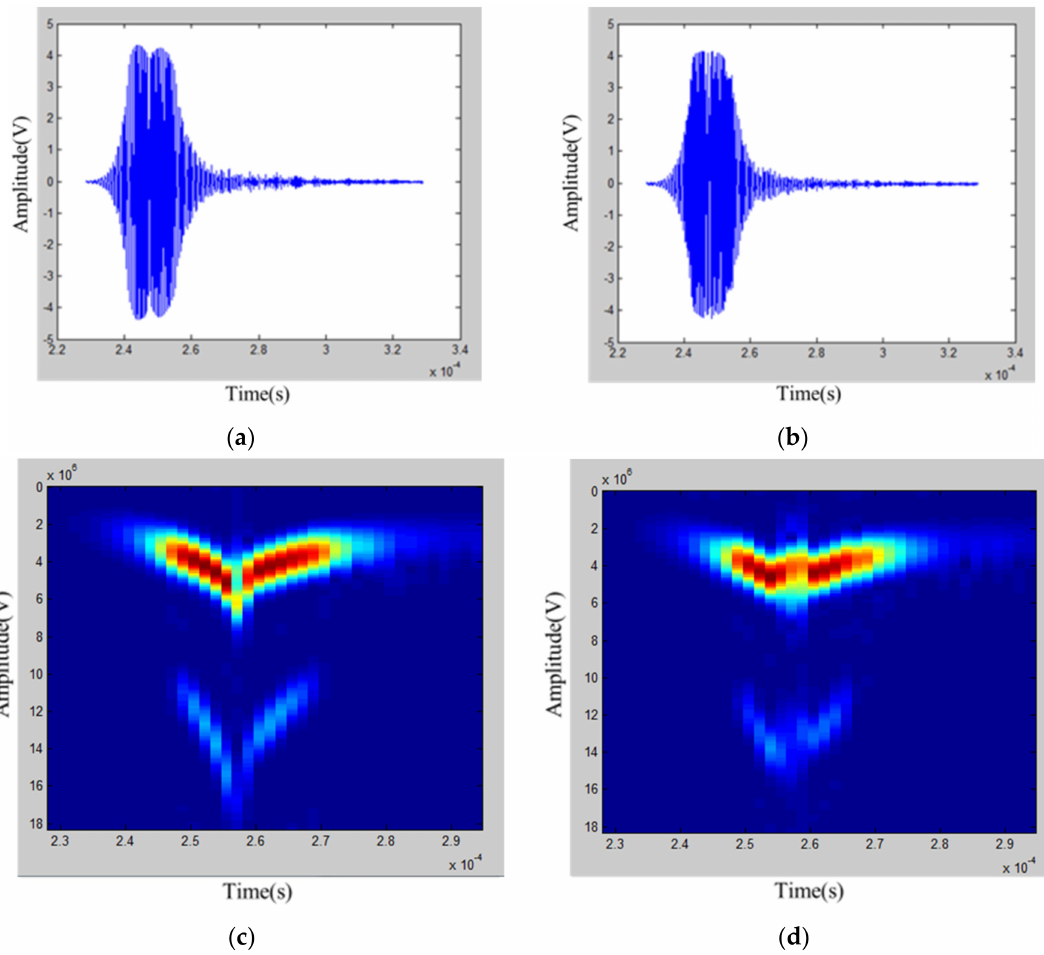
Figure 4. ( a ) Received ultrasonic GW signals from specimens without and ( b ) with defects in the time domain, and ( c ) STFT results for specimens without and ( d ) with